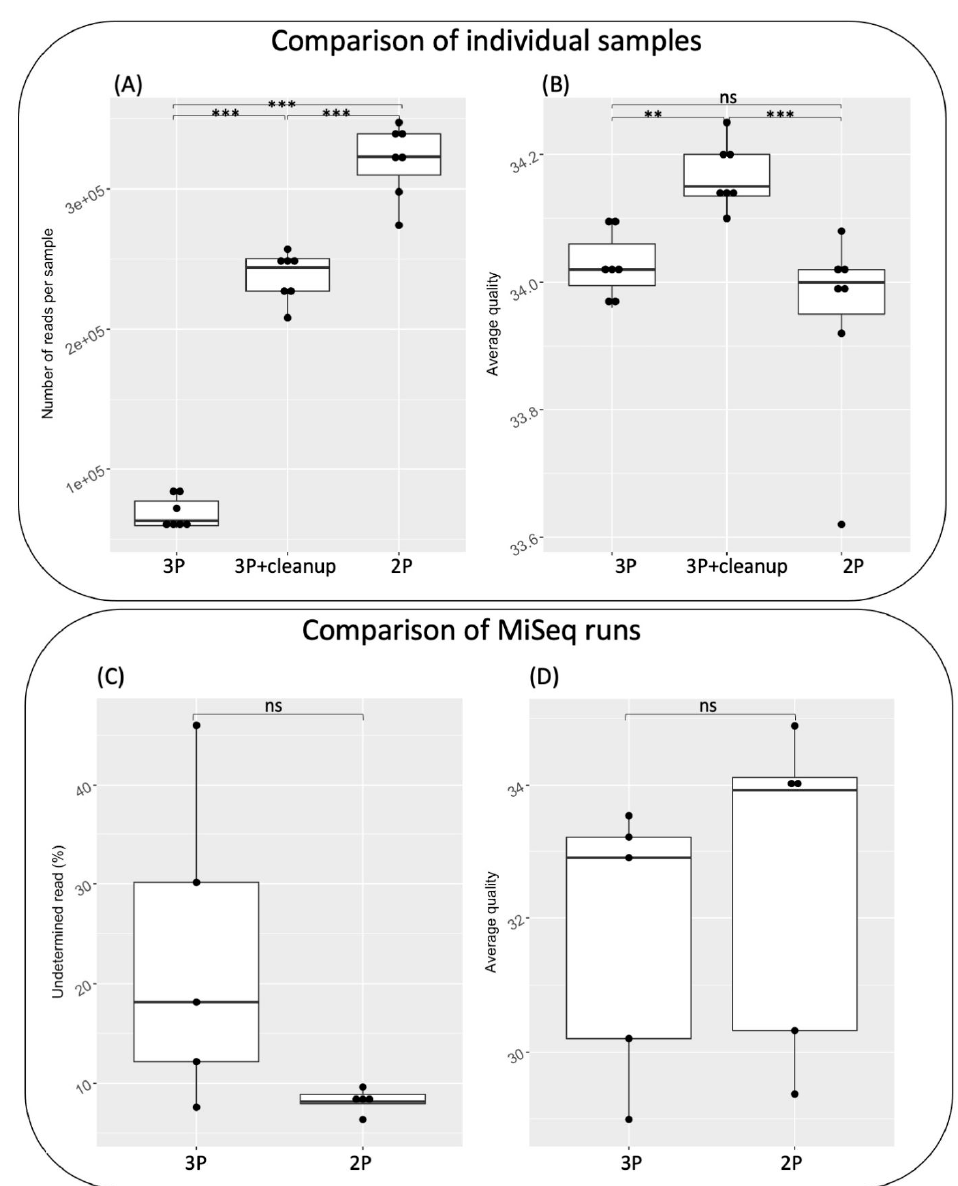
Figure 5. Sequencing result comparisons. All sequencing was conducted at the sequencing core at Duke University Center for Genomic and Computational Biology (datasets 2 and 3). ( A , B ) Individual samples prepared with the three-step PCR (3P), three-step PCR with bead clean-up (3P+cleanup), and two-step PCR (2P) protocols (Supplementary Table S4). All samples were prepared with the 515F-806R primer set targeting bacteria and archaea (dataset 2). ( A ) Number of reads received and ( B ) average quality of reads (Phred score) for 3P, 3P+cleanup, and 2P per sample. ( C , D ) Independent Illumina MiSeq runs of 2P vs. 3P protocols (dataset 3, Supplementary Table S5). ( C ) Percentage of undetermined reads (i.e., reads that could not be assigned to a sample due to unrecognizable barcode) and ( D ) average quality of reads in 3P vs. 2P across independent Miseq runs. Significance label for p -value and FDR: ns = not significant (>0.05), ** <0.01, ***